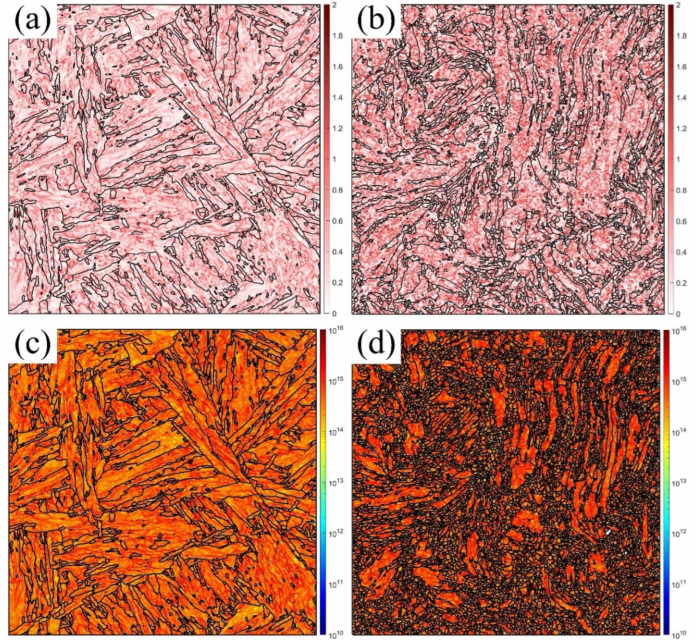
Figure 11. KAM and GND maps for the medium ( a , c ) and maximum ( b , d ) degrees of deformation at 630 ◦